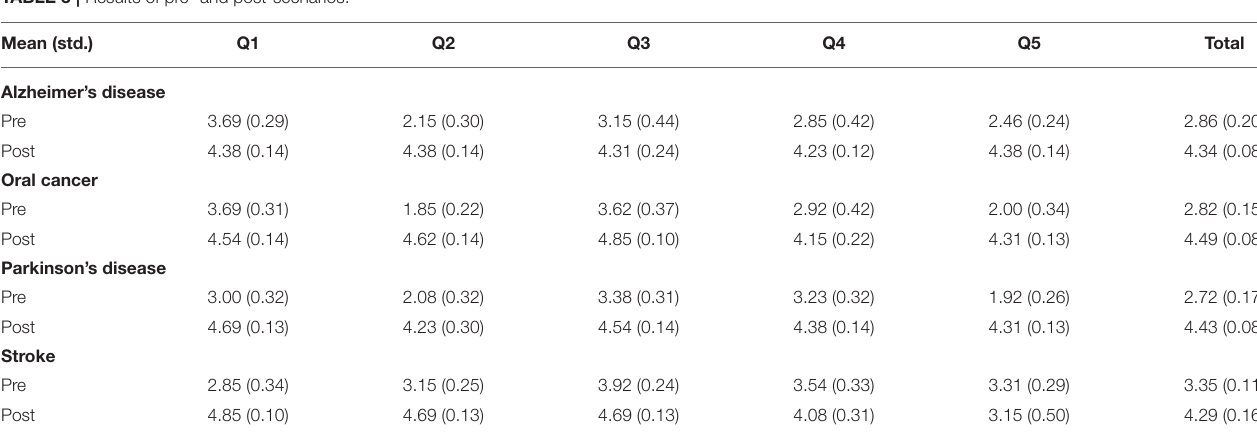
TABLE 3 | Results of pre- and